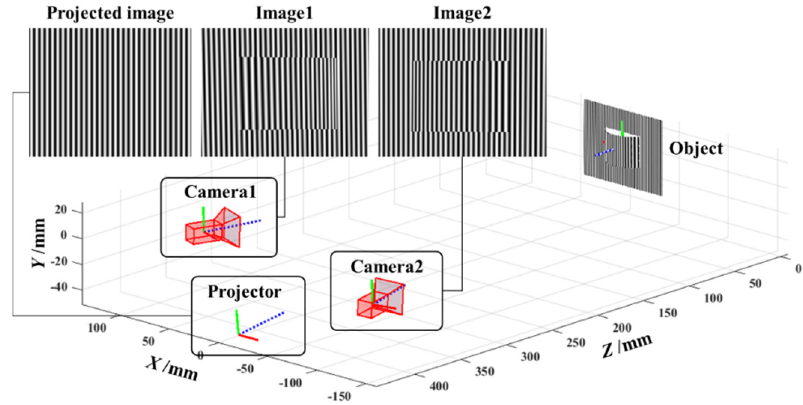
Figure 4. Digital simulation of 3D-sample moiré.